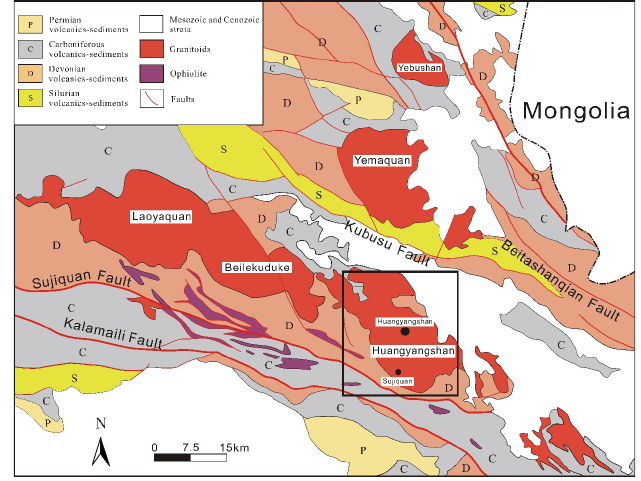
Figure 1. Simplified geological map of the Kalamaili area, Eastern Junggar (modified after [4]). 2.2. Huangyangshan Complex The Huangyangshan graphite deposit is located in the northern segment of the Kara- maili fault and within the Huangyangshan alkaline granite complex. The graphite-hosting